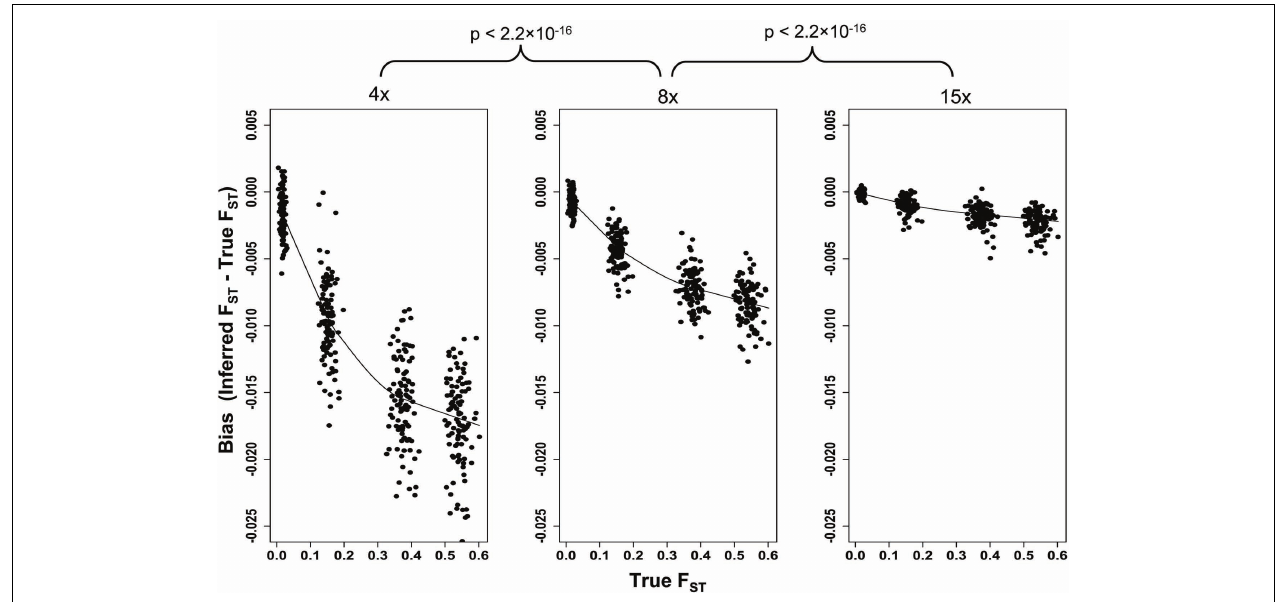
sequencing depth to illustrate both the effect of increasing F ST as well as read depth.The difference between pre- and post-sequencing F ST was calculated for all simulations ( n = 100 for each value of F ST ) and these differences were compared between sequencing depths using a paired t